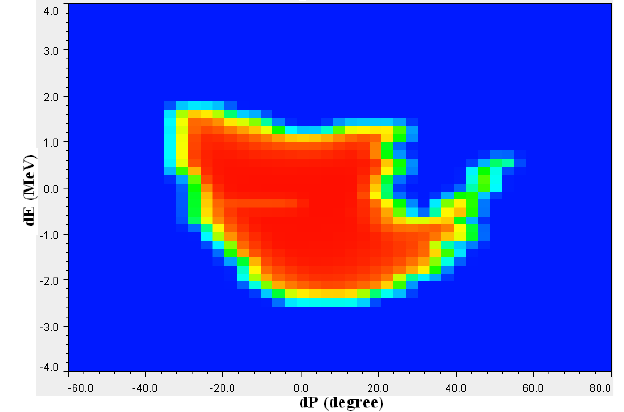
FIG. 6. (Color) Longitudinal acceptance measured at the second SCL cavity with the sum of all the linac BLMs.